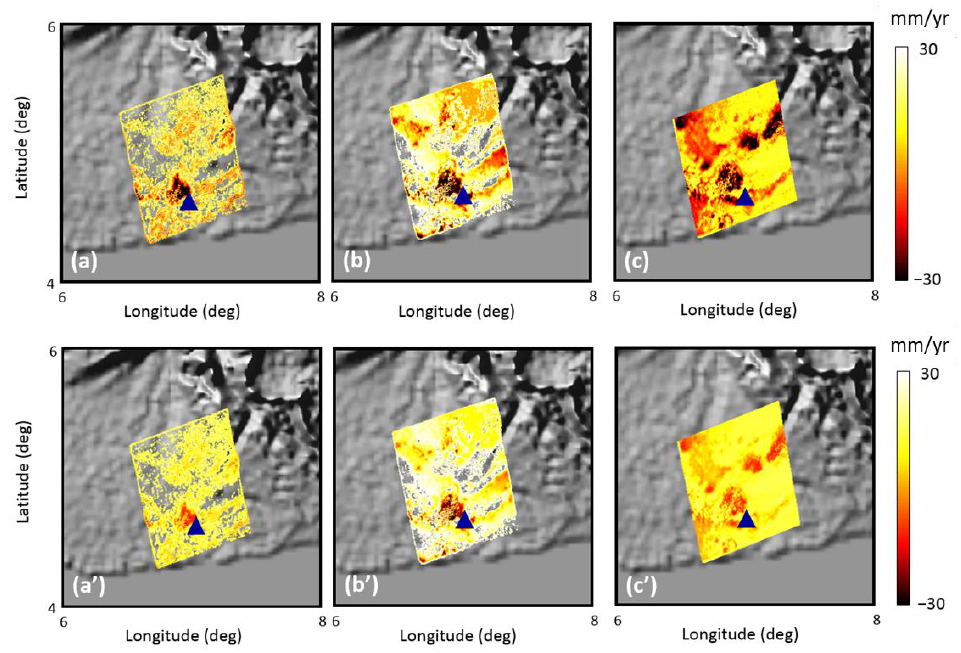
Figure 7. Obtained mean displacement rate from raw (( a ): PSI, ( b ): SBAS, and ( c ): InSAR) and corrected (( a ’ ): PSI, ( b ’ ): SBAS, and ( c ’ ): InSAR) interferograms.